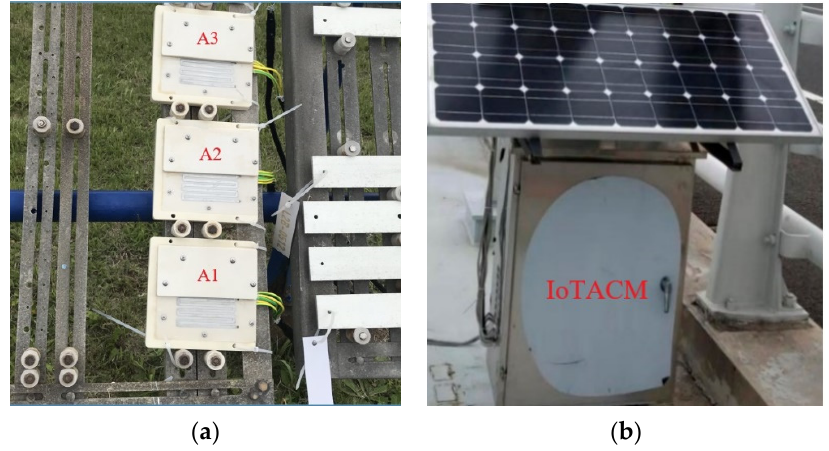
Figure 2. The field corrosion tests at Qingdao, China. ( a ) Three Q235 steel specimens; ( b )